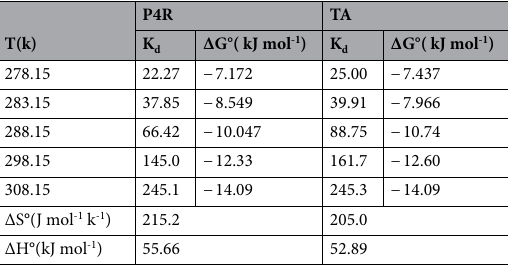
Table 6. Adsorption thermodynamic data of ZnS/CuO-CNT towards TA and P4R food